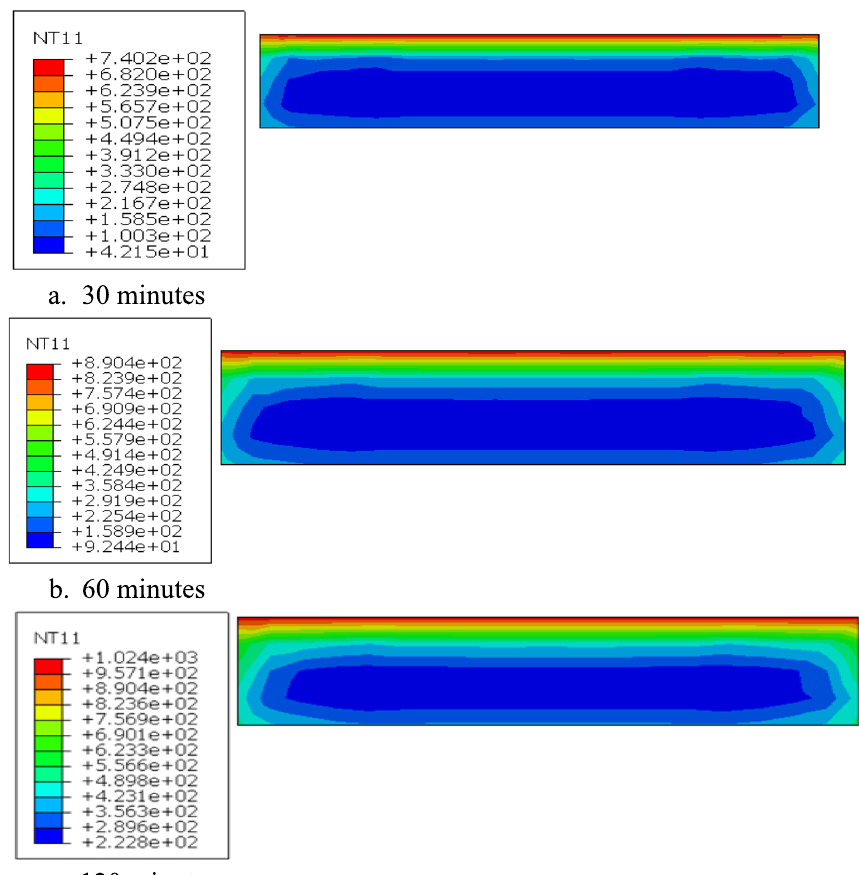
Fig. 37 Temperature distributions across the cross section of wall for different fire durations. a 30 min. b 60 min. c 120